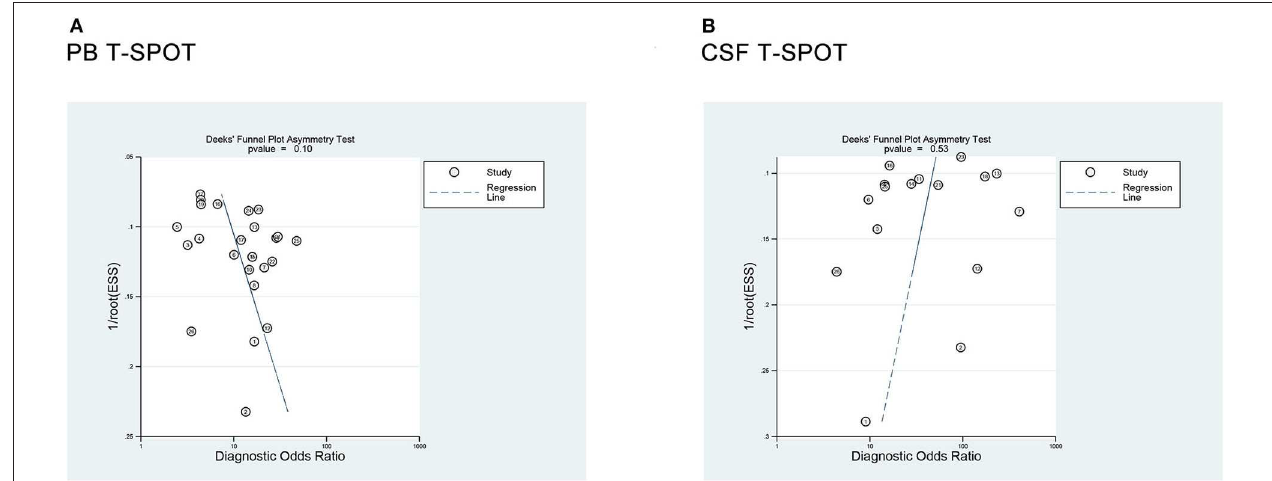
FIGURE 7 | Deeks’ funnel plot asymmetry test for the evaluation of potential publication bias in (A) PB T-SPOT and (B) CSF T-SPOT studies. PB, peripheral blood; CSF, cerebrospinal fluid.